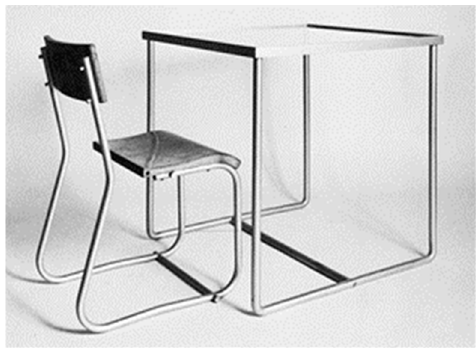
Figure 23. Chromium aluminum, crystal, and wood table and chairs by Gigi Chessa and Umberto Cuzzi (1931–1932). Photo from (Selvafolta 1980, p. 33).